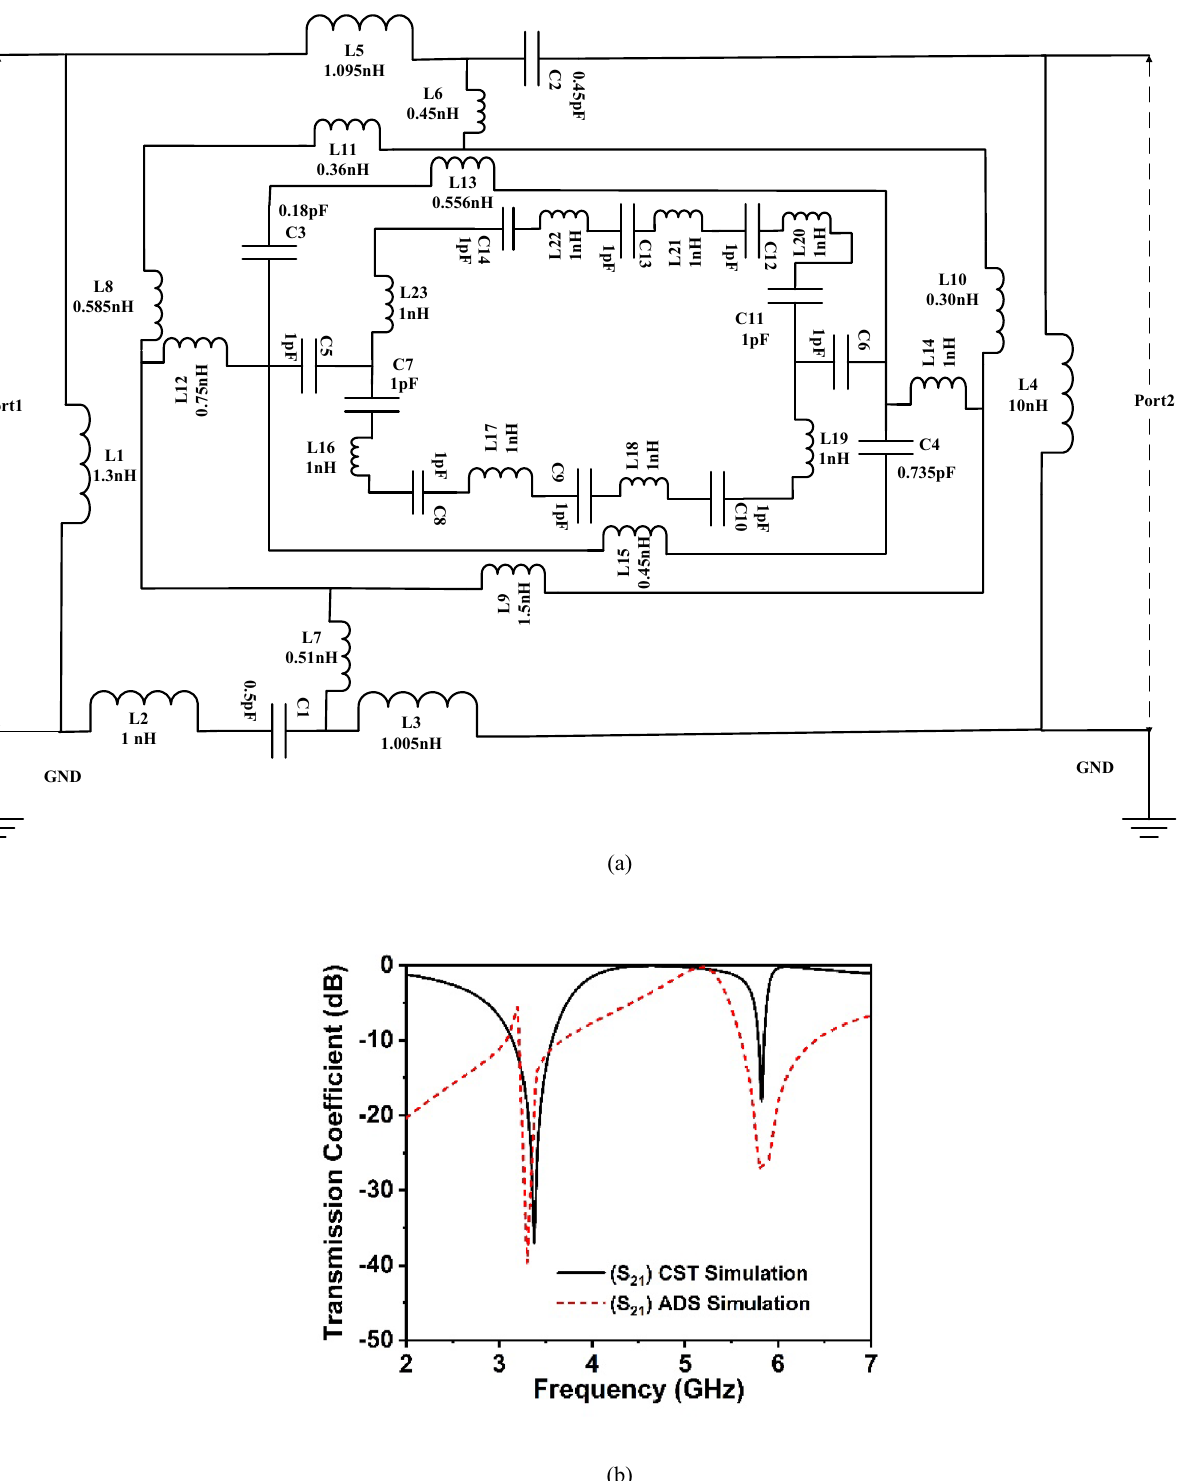
Figure 15. ( a ) Equivalent circuit (EC) model of the proposed CRECGR unit cell and ( b ) comparison of S 21 for CST and equivalent